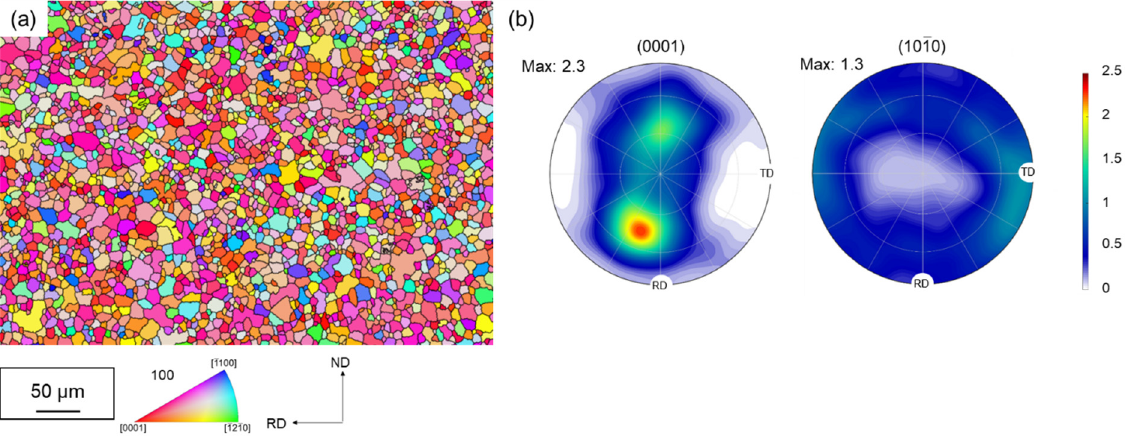
Figure 4. Microstructure and texture of the ZAX210 sheets: ( a ) EBSD-Map and ( b ) pole